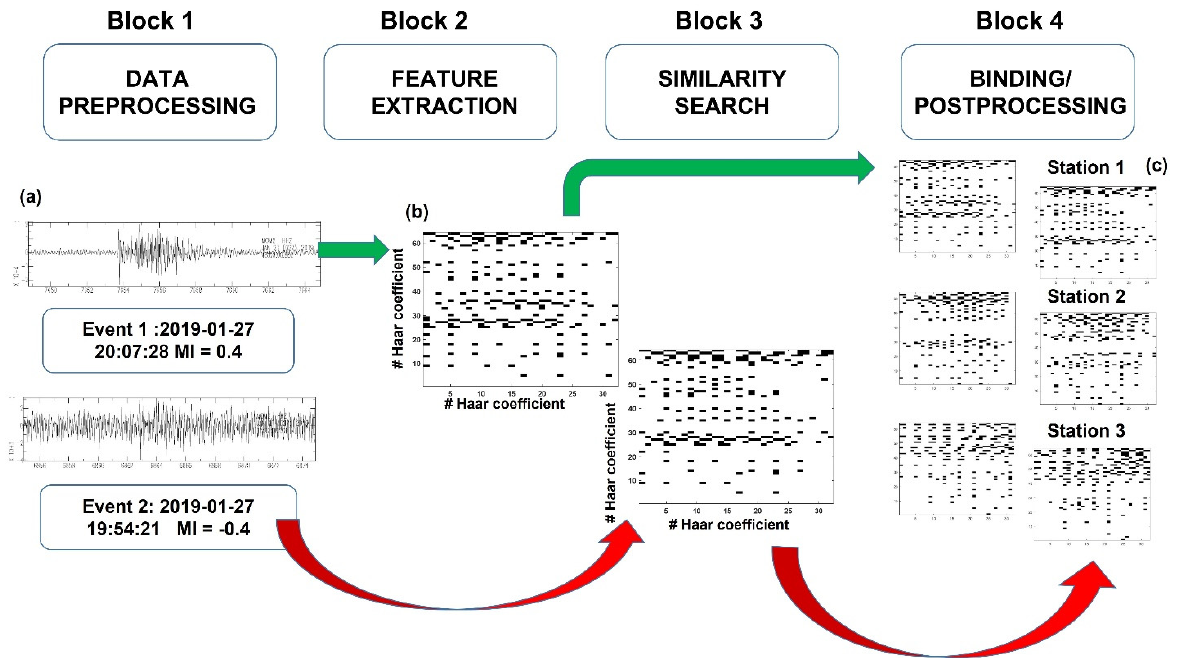
Figure 3. Top, with blue arrows: Workflow of the FAST data processing for microseismicity detection. Bottom: an application example based on two events included in the Table 1 (see Section 4): ( a ) signals in time domain; ( b ) binary fingerprints comparison at a single station; ( c ) binary fingerprints comparison at network level.